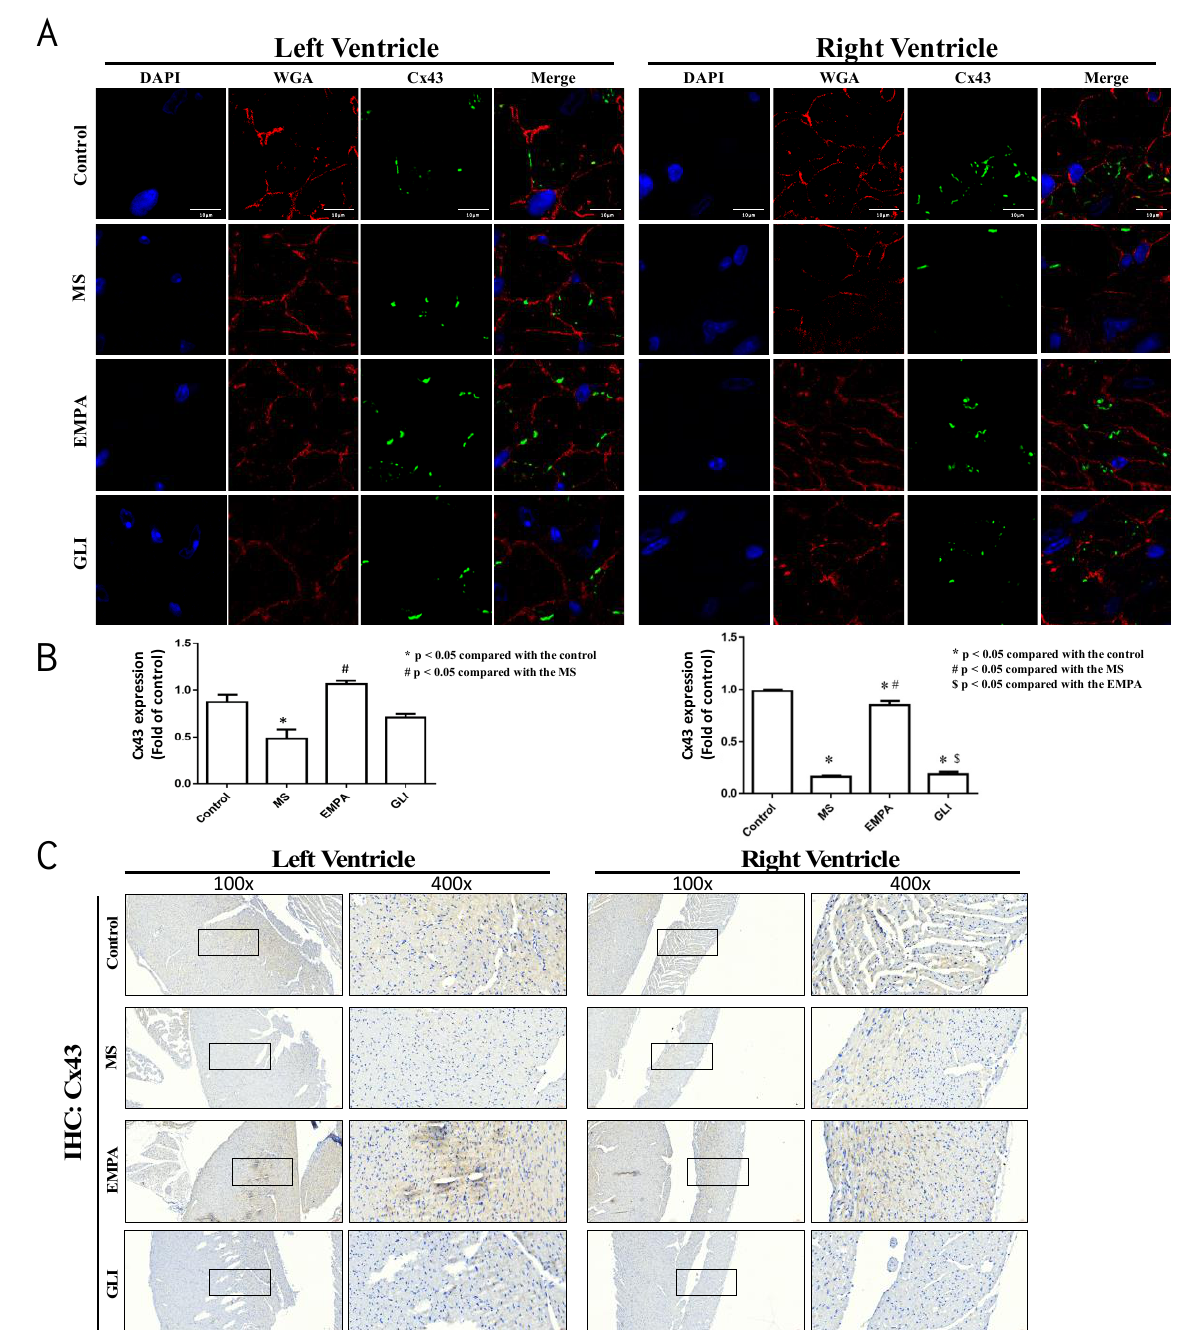
Figure 4. Histological analysis of Cx43 expression in mouse ventricles. ( A ) Immunofluorescence of Cx43 confocal image in the LV (left panel) and the RV (right panel) among the study groups ( n = 5 for each group). Nuclei with DAPI staining appear blue. The plasma membrane with WGA staining appears red, and green for Cx43-positive staining. The scale bars indicate 10 μm. ( B )The quantification of Cx43 signaling integrated from a series of confocal image sections in ventricles among the study groups. ( C ) IHC staining of Cx43 in mouse ventricles of each group. Blue is used for cell nucleus staining and brown for Cx43-positive staining. *: p < 0.05 compared with the control group; #: p < 0.05 compared with the MS group; $: p < 0.05 compared with the EMPA group.